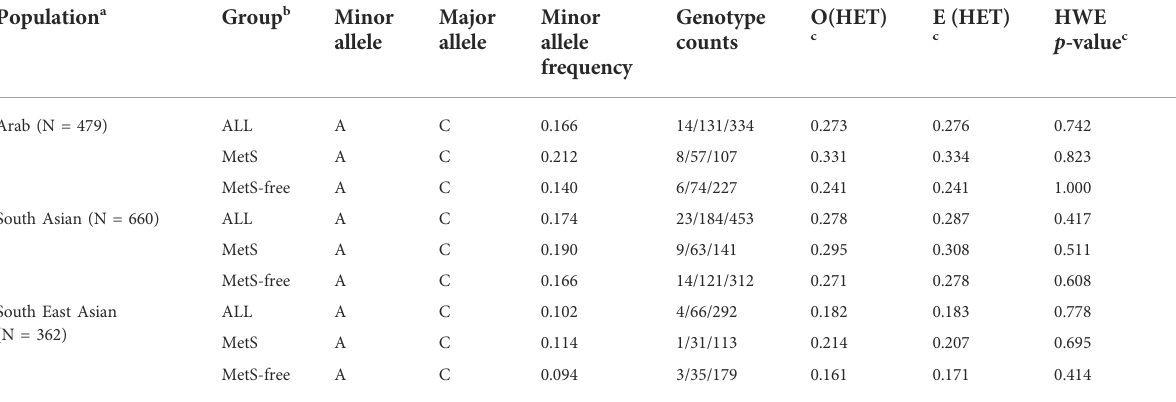
TABLE 2 Assessment of Hardy – Weinberg Equilibrium (HWE) deviation for rs1997623 genotypes across sample sets of MetS, MetS- free and All individuals among Arab, South Asian and South East Asian